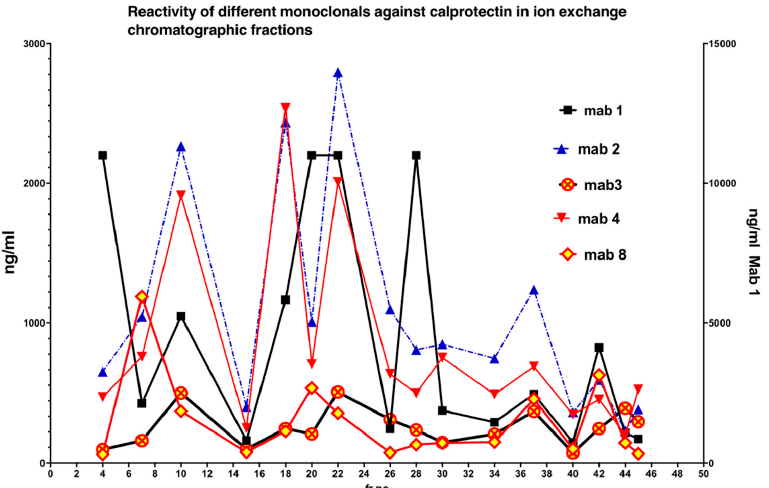
Figure 5. The five monoclonals gave different patterns when the chromatographic fractions (shown in Figure 3) were tested, suggesting that they bind to different and/or multiple epitopes on CP in the fractions. A mixture of monoclonals (MiMo) should be selected and used for testing of fecal